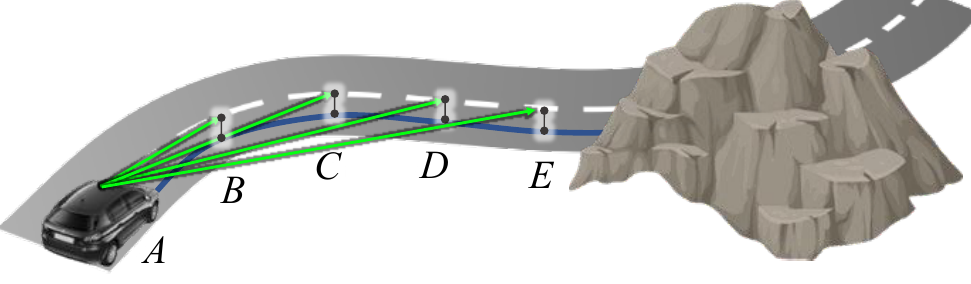
Figure 1. Sketch of sightlines projection and the ASD.